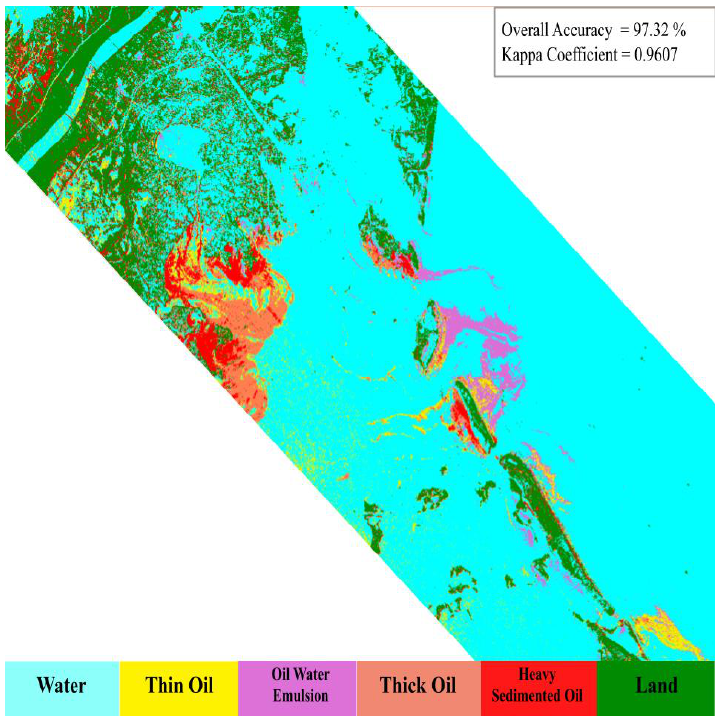
Figure 14. SVM Classification image for proposed log transformed